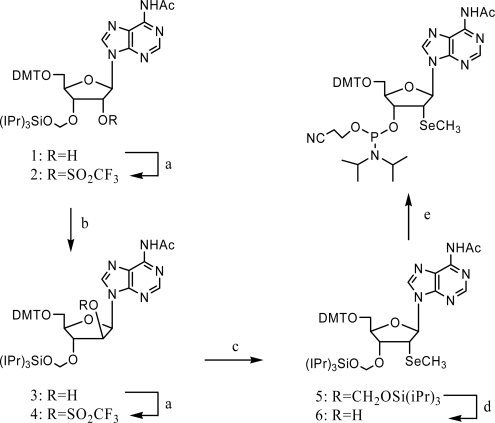
Synthesis of the 2’-Se-methyladenosine phosphoramidite. Reagents and conditions: (a) 1.5 equiv. trifluoromethanesulfonyl chloride, 1.5 equiv DMAP, 2.5 equiv NEt3, in CH2Cl2, room temperature, 20 min; (b) 8.3 equiv CH3COO−K+, 2.5 equiv. (iPr)2NEt, 3.3 equiv. 18-crown-6-ether, in toluene, 80 °C, 11 h [54% over (a) and (b)]; (c) 6 equiv. NaBH4, 2 equiv. CH3SeSeCH3, in THF, 30min; (d) 1 M TBAF, 0.5 M acetic acid, in THF, r.t. 2.5 h, 84%. (e) 1.5 equiv. (2-cyanoethyl)-N,N-diisopropylchlorophosphoramidite, 10 equiv. CH3CH2N(CH3)2, CH2Cl2, r.t, 2 h, 91%. (DMT: dimethoxytrityl, DMAP: 4-(dimethylamino)pyridine; TBAF (tetrabutylammonium fluoride).